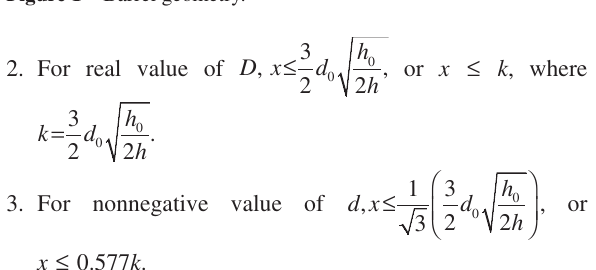
Figure 1 Barrel